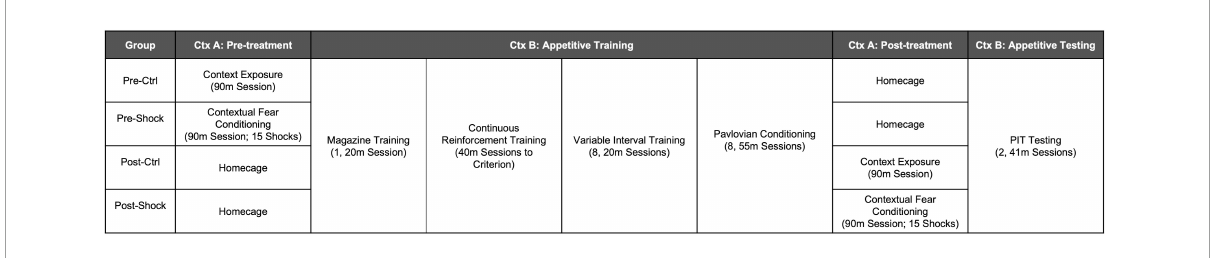
FIGURE1 Illustration of the experimental timeline for Experiment 1.